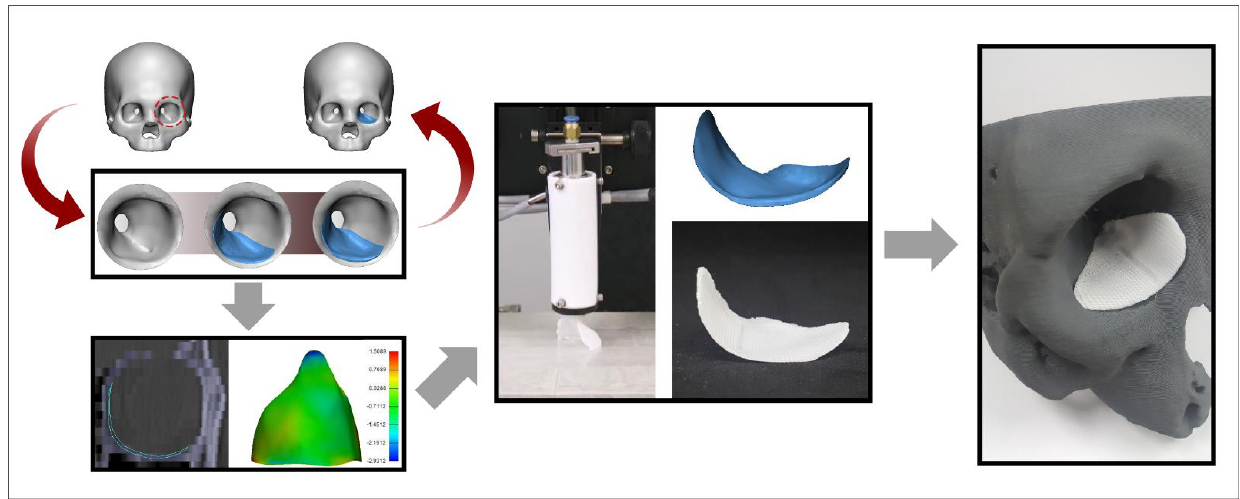
Figure 1. Graphical abstract of fabrication of 3D-printed orbital implant.